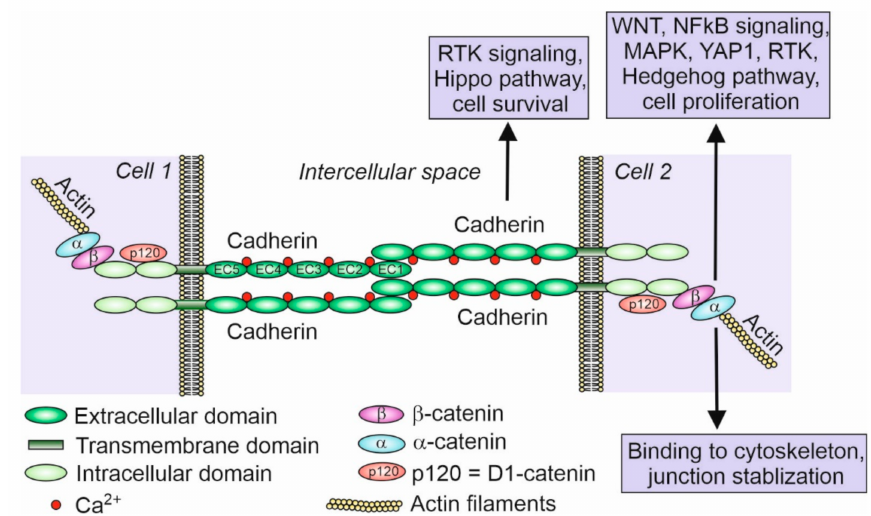
Figure 1. Scheme of classical cadherin binding between two cells. Classical cadherins, such as E- and N-cadherin, possess five extracellular domains (EC1–EC5), which bind Ca 2 + ions, a transmembrane domain, and two intracellular domains. Intracellular domains bind p120 protein (D1-catenin) and β -catenin that binds α -catenin, which in turn binds actin filaments. Although there are many examples of cadherin and associated catenin signaling participating in various pathways (indicated in